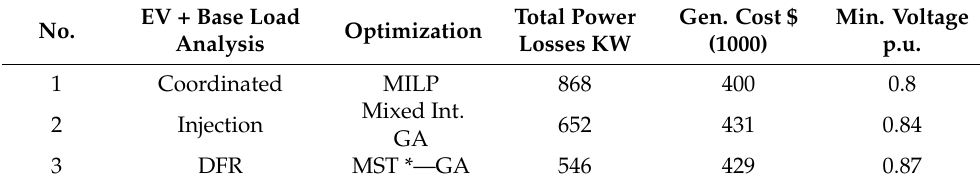
Figure 12. Bus loads comparison for three techniques. Table 3. Power Losses and Cost Comparison.